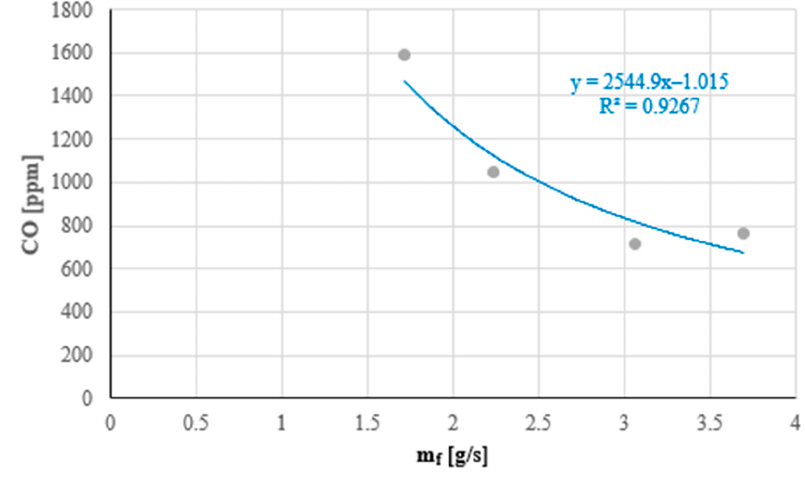
Energies 2022 , 15 , 6187